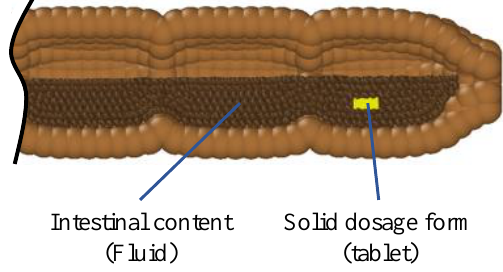
Figure 6. Representation of the initial position of the tablet, which is in all models identical.